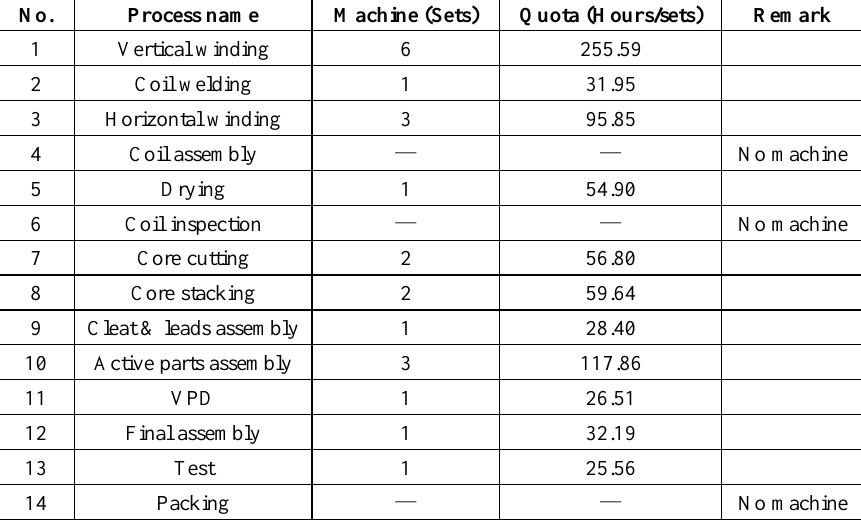
Table 1. Man-hour Quota of each